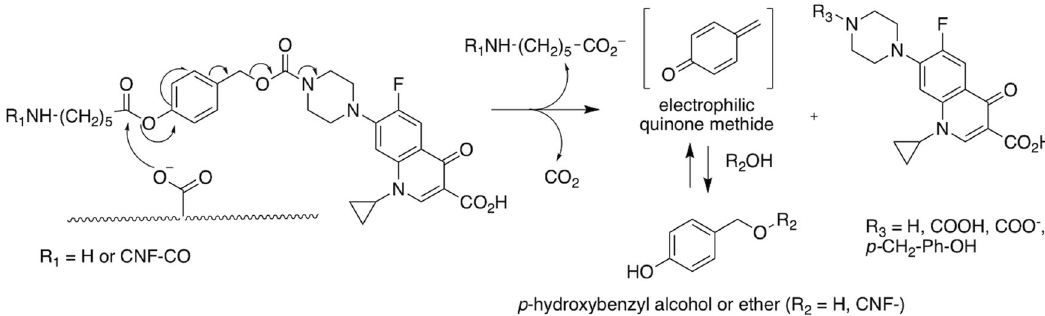
Fig. 7 Expected mechanism for CNF-COO- base-catalyzed cleavage of the prodrug at neutral pH. The carboxylate present at the surface of CNFs can catalyze the ester bond cleavage and the release of cipro